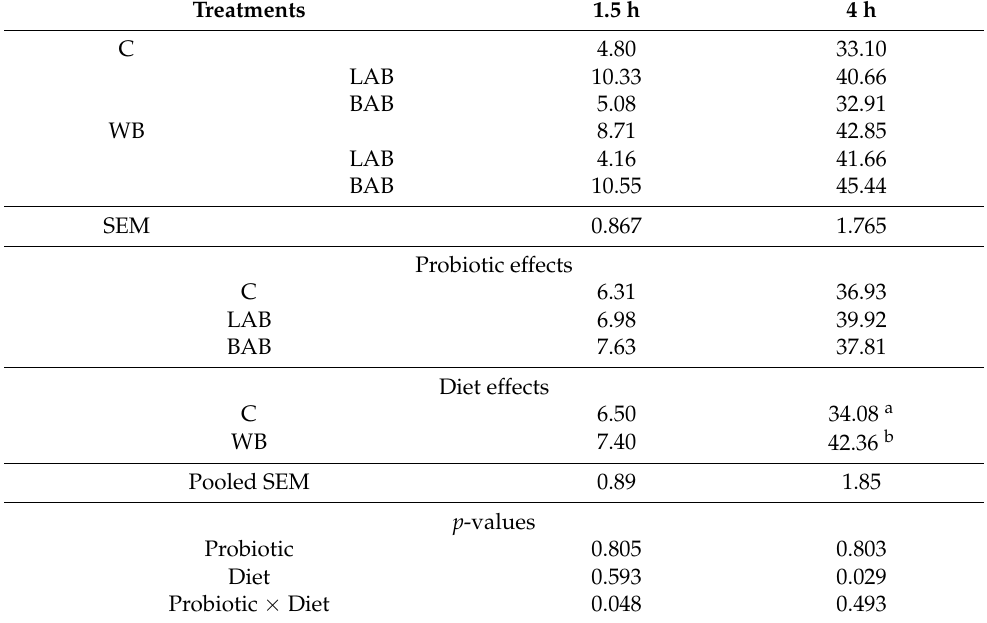
Table 4. Treatment effects on the in vitro NH 3